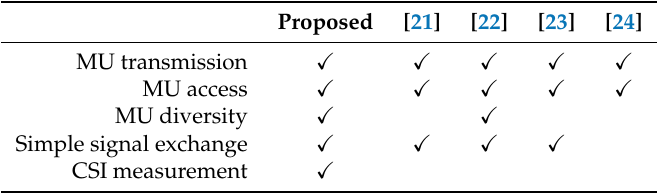
Table 2. Comparison with other OFDMA protocols.